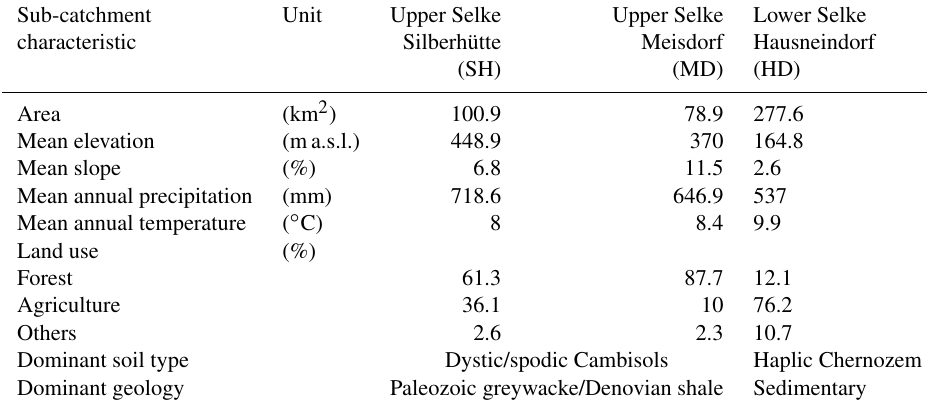
Table 1. Sub-catchment specific characteristics of the Selke catchment.